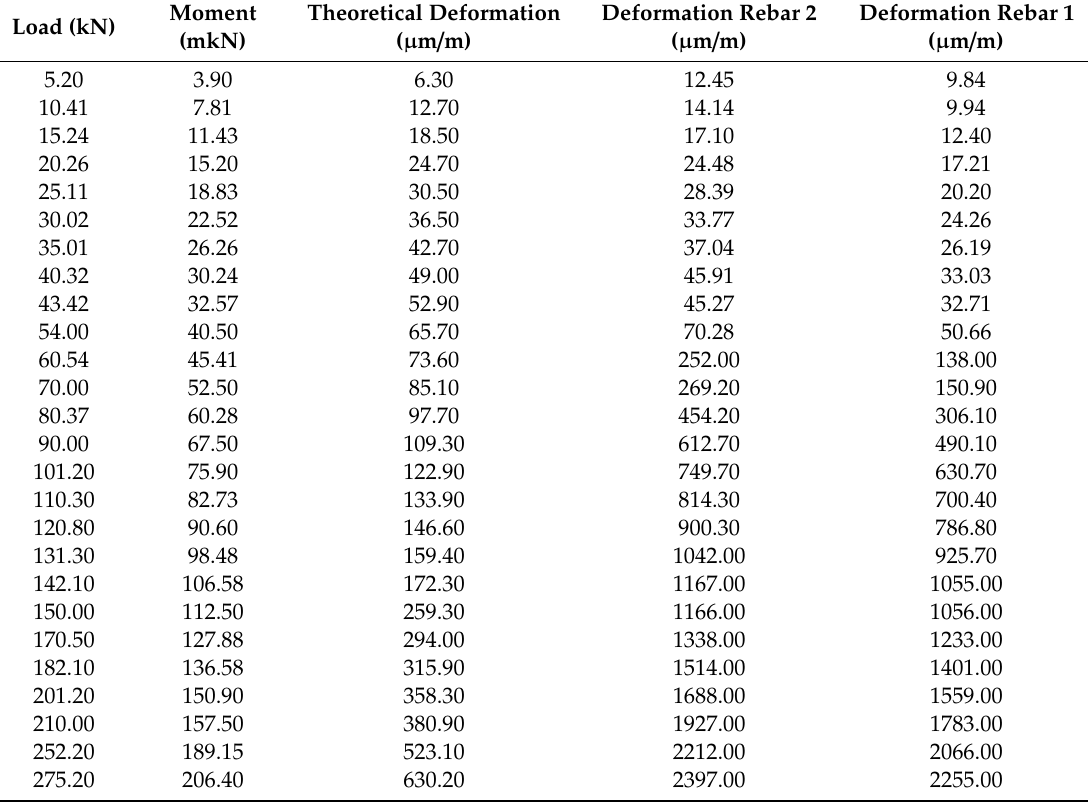
Table 9. Theoretical deformation of the rebars 1 and 2 for M fis = 111.25 mkN and f ct = 8.90 MPa with